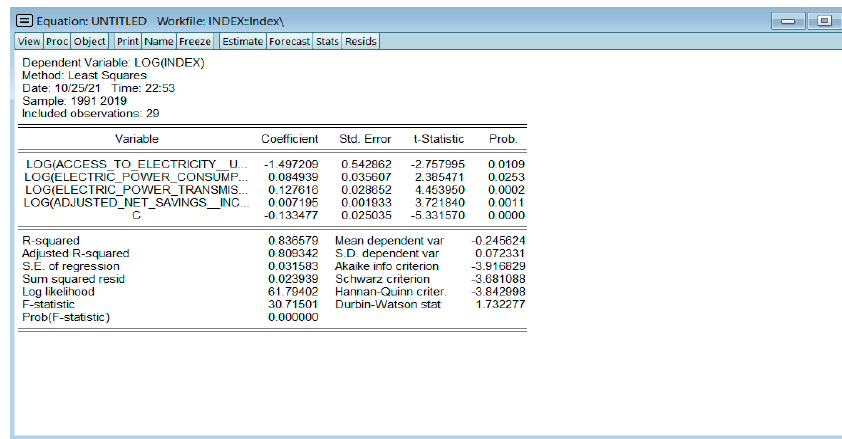
Figure A1. Eviews regression result (Ukraine case).